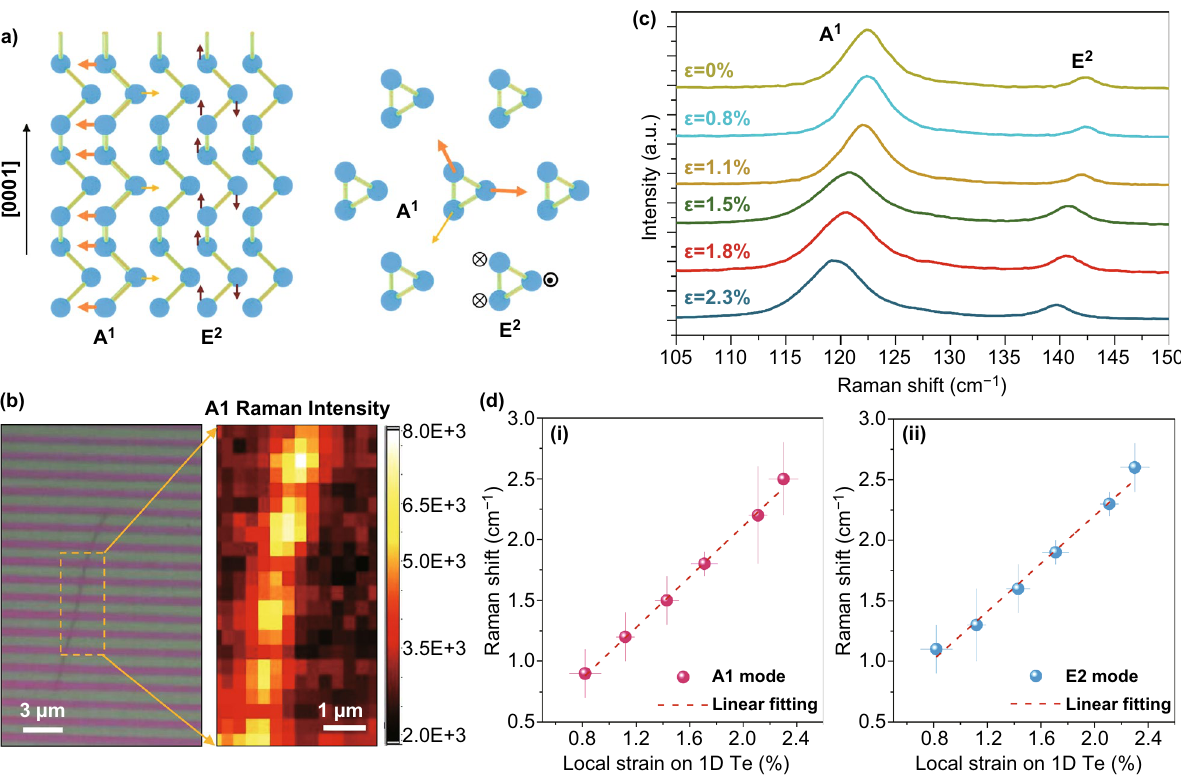
Fig. 4 Raman spectroscopy results of the strained 1D Te nanowire. a Schematic shows the main Raman-active modes in Te crystal. b Optical image and Raman intensity mapping of the deformed 1D Te nanowire. c Raman spectra of the deformed 1D with different local strain. d Quan- titative analysis of the Raman frequency shift of the deformed 1D Te with different local strains. The average values from 3 technical replicates are indicated, and error bars represent one standard deviation for each set of